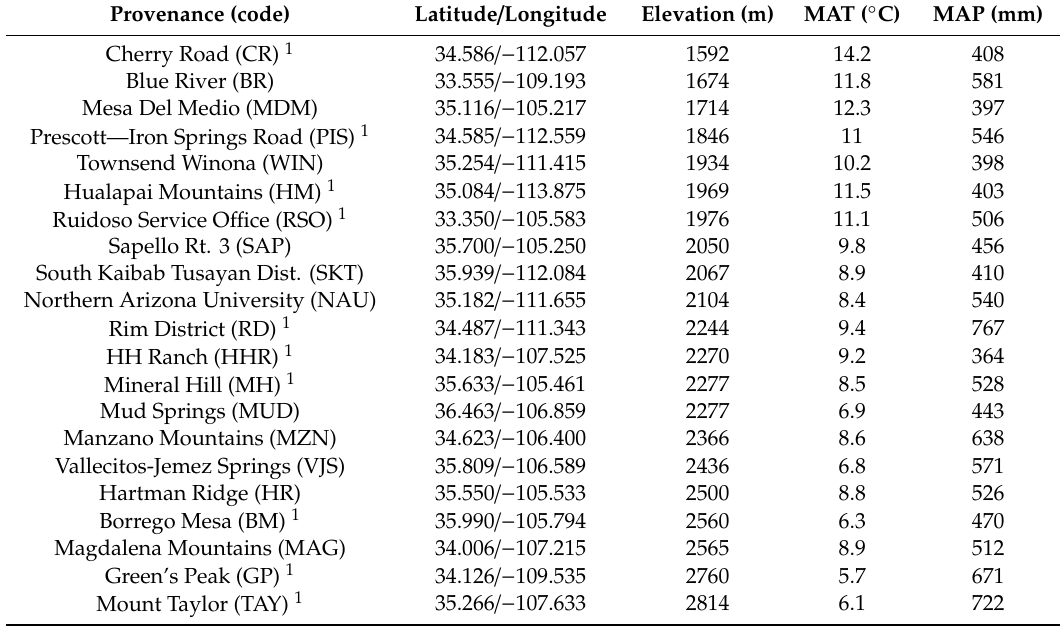
Figure 1. Location map of the 21 provenance collection sites (white circles) of Pinus ponderosa and the location of the field common garden (black triangle). Table 1. Provenance name, code, latitude, longitude, elevation, mean annual temperature (MAT), and mean annual precipitation (MAP) ordered by increasing elevation. Climate data (30 year normal, 1981–2010) are from PRISM (PRISM Climate Group, Oregon State University, http: // prism.oregonstate. edu, created 19 September 2020). Values are means over mother trees at each